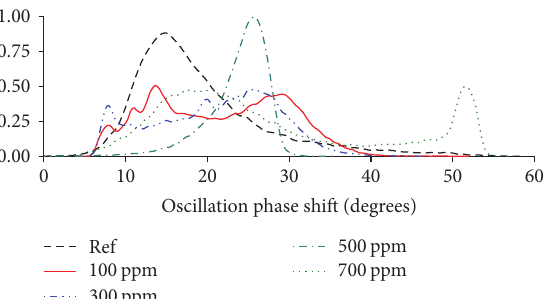
Figure 4: Phase histogram of PS sample containing Ag/TiO 2 nanoparticles. Wide, bimodal histogram is observed for 100, 300, and 700 ppm of Ag/TiO 2 , showing the presence of PS and the additive. On the contrary, reference and the sample containing 500 ppm of Ag/TiO 2 produce a unimodal distribution indicating that the additive homogenously covers the PS surface.